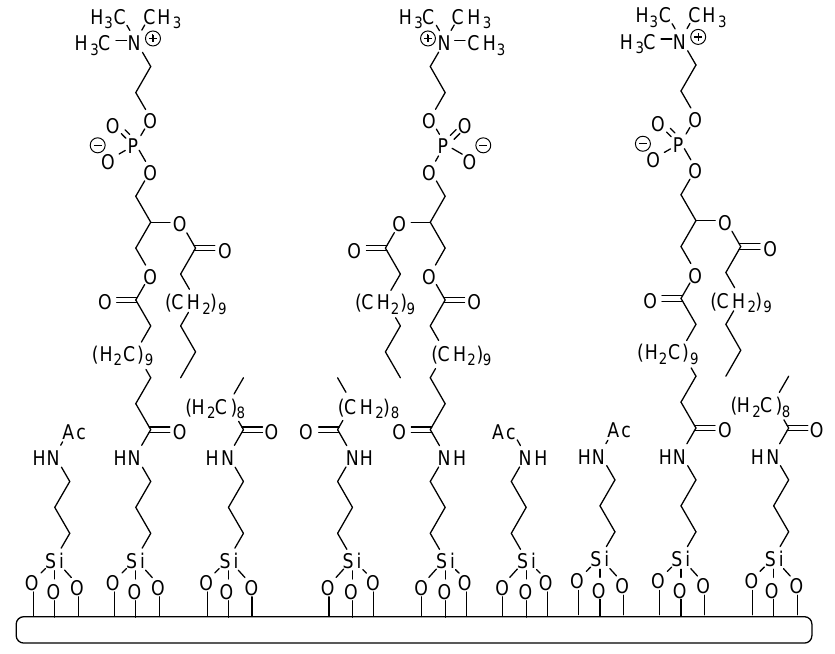
Figure 3. Amphiphilic phospholipids covalently bonded to aminopropyl silica in the IAM.PC.DD2 column.